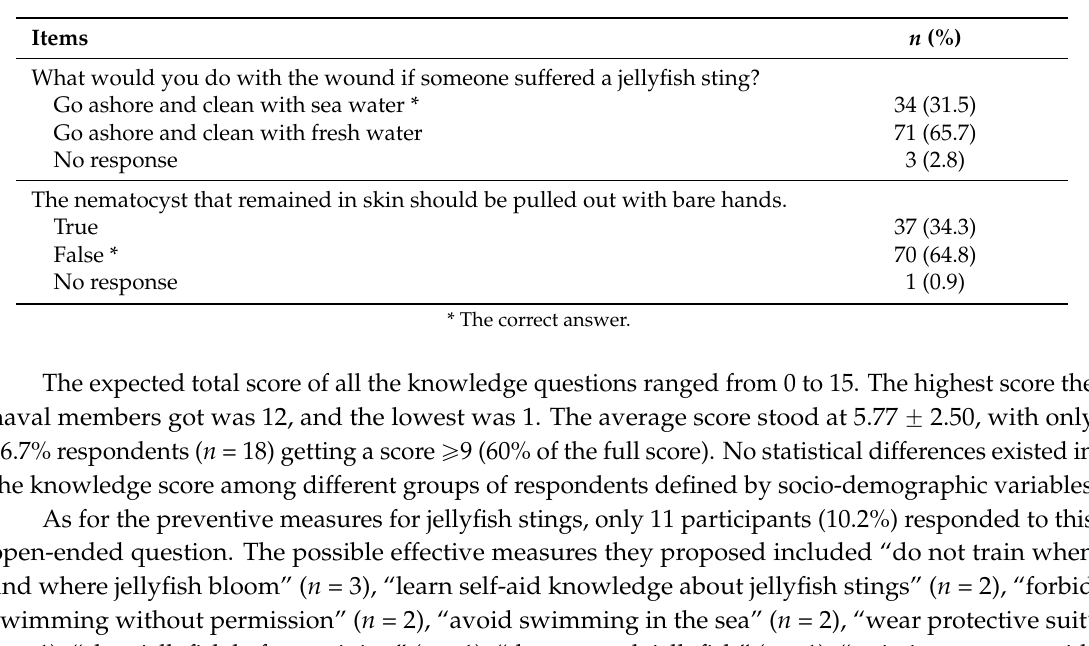
Table 4. Knowledge about first aid ( n =